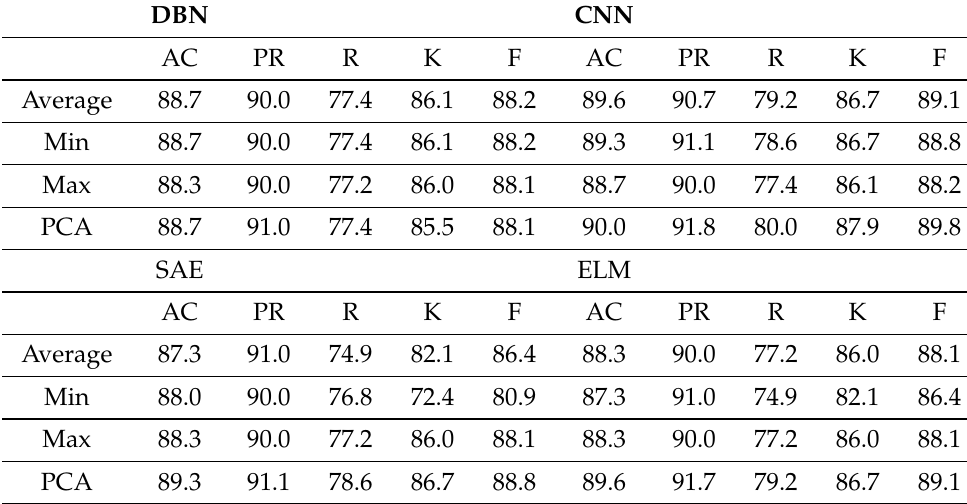
Table 4. Accuracy (AC), Precision (PR), Recall (R), Cohens kappa (K), and F-measure (F) values in percentage for the analyzed spatial fusion methods and classification algorithms using spatial fused data as input.